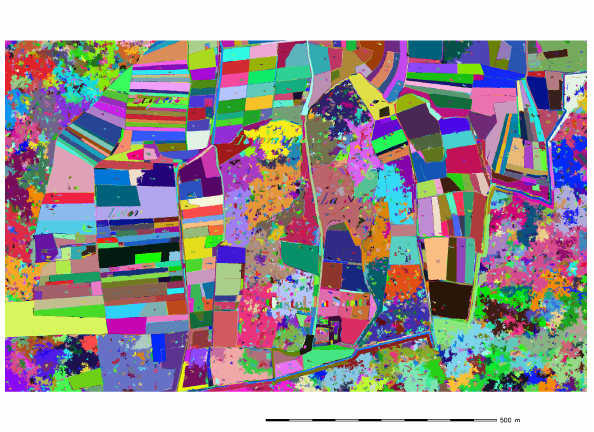
Figure 5. Segments for threshold value of 0.1 and minimum number of cells in a segment of 25 - particular.